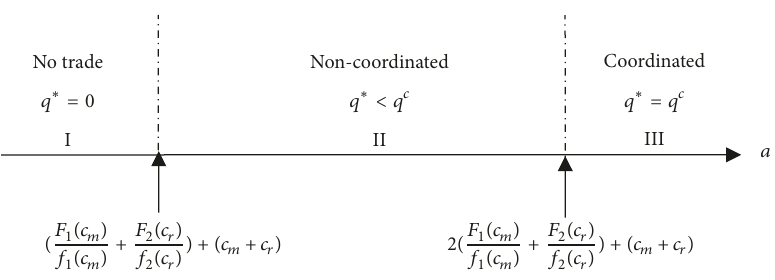
Figure 3: Supply chain coordination